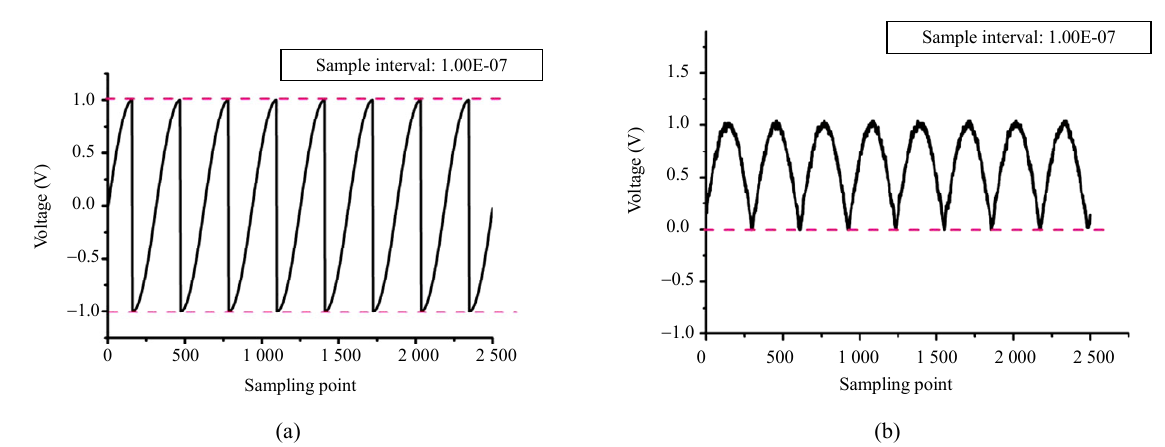
Fig. 2 Measurement results at the balance modulator output for: (a) “in-quadrature” and (b) “in-phase”